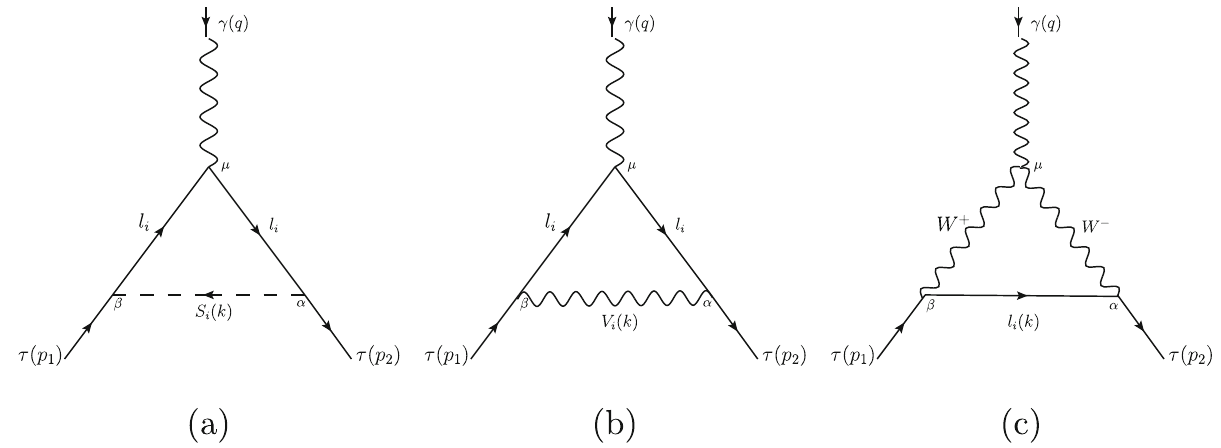
Fig. 13 Generic Feynman diagrams that contributes to the AMDM of the tau-lepton, l i ≡ τ,ν τ . a Scalar contribution, S i ≡ h 0 . b , c Vector contributions, V i ≡ γ, Z